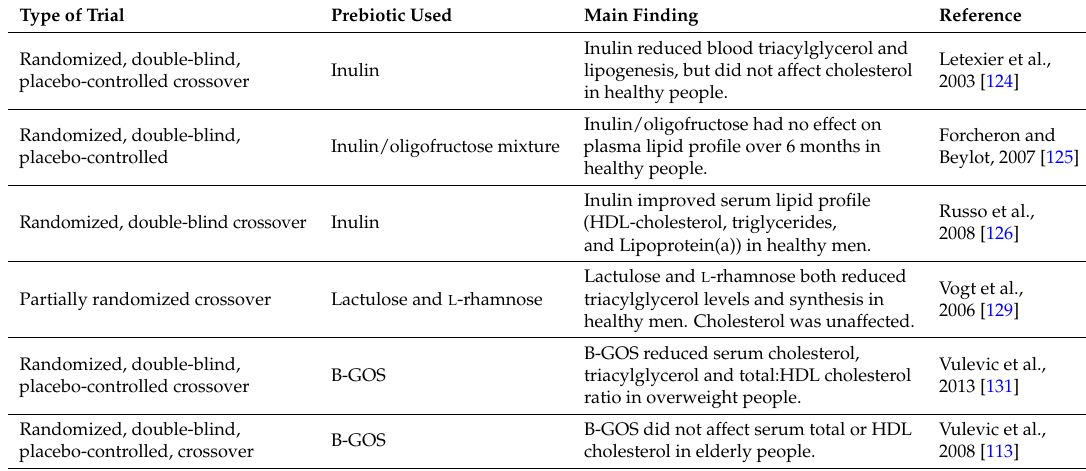
Table 4. Summary of findings from human prebiotic interventions on serum lipid